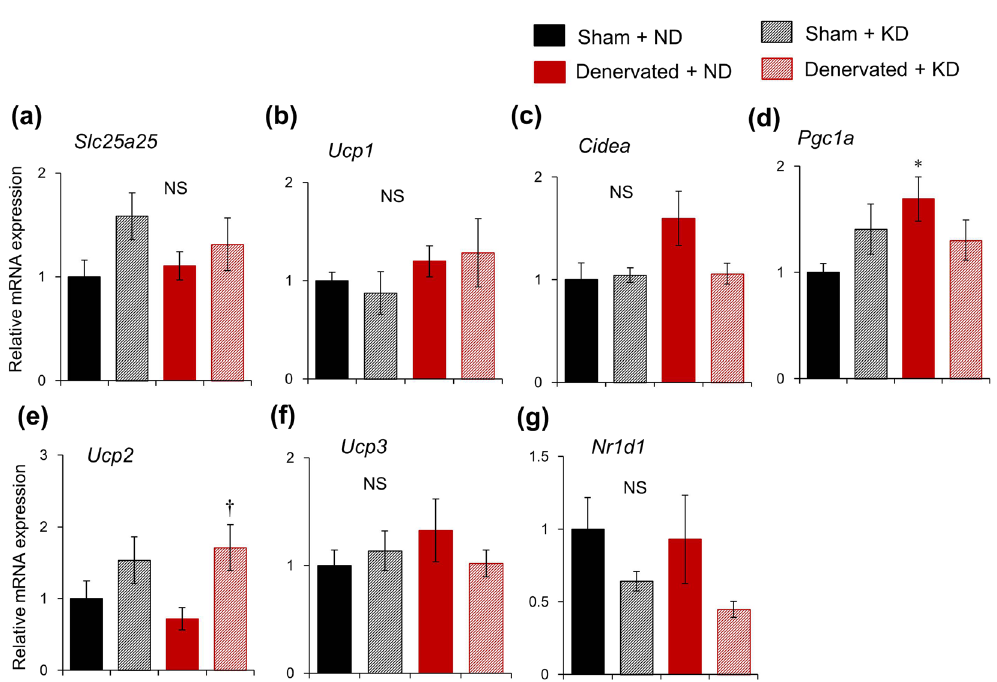
Figure 3. Messenger RNA expression of thermogenic gene in brown adipose tissue. Prolonged ketogenic diet (KD) feeding minimally affects thermogenic gene expression in brown adipose tissues of mice fed with KD or normal diet (ND) for seven days starting at 10 days after sciatic denervation or sham-operation. Data are expressed as means ± SEM (n = 5 per group). Value for sham-operated mice fed with ND is expressed as 1.0. * P < 0.05 for sham-operated vs. denervated. † P < 0.05 for ND vs. KD. Supplemental Table 4 shows results of statistical